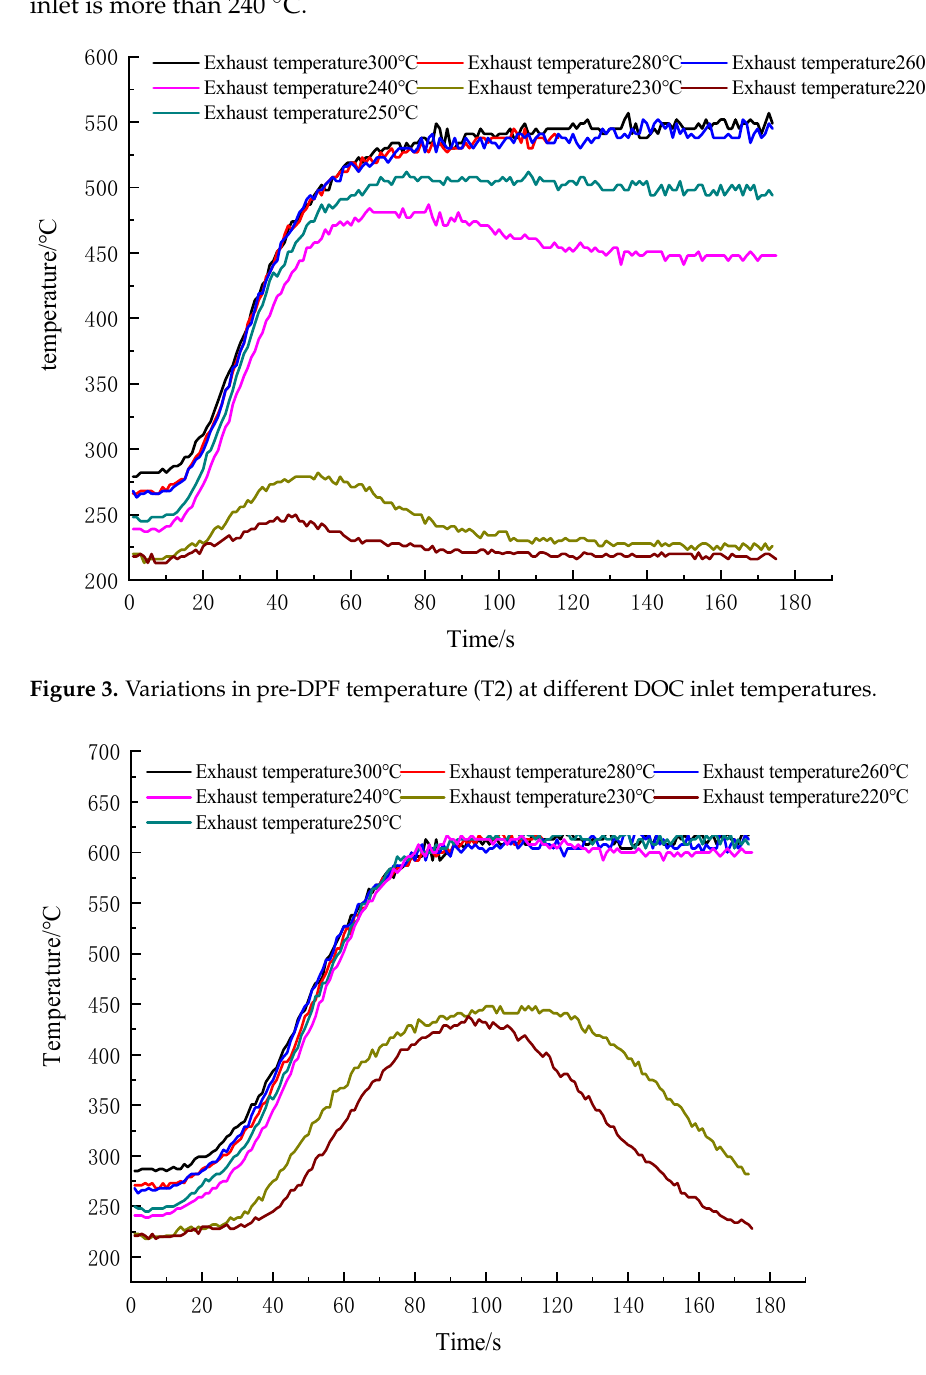
Figure 4. Variations in post-DPF temperature (T3) at different DOC inlet